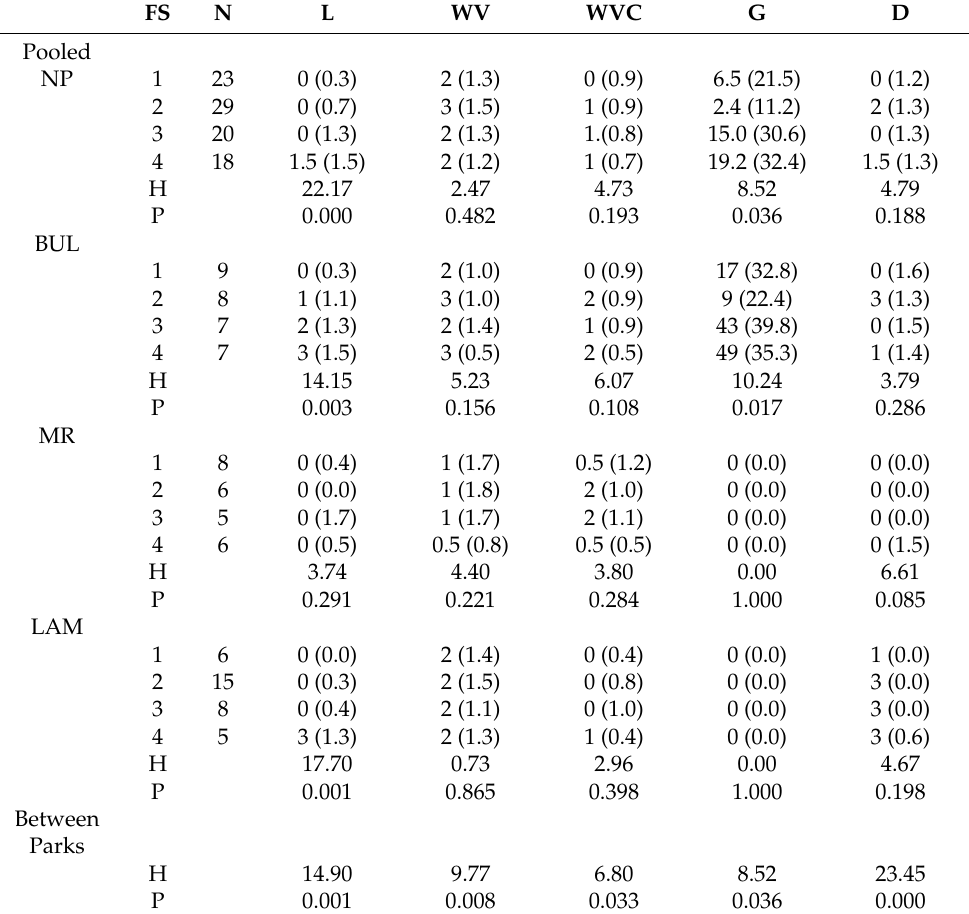
Table 3. Summary table showing the mean or median results of fire-promoting regrowth, for each fire severity in each NP, as well as for pooled NP data. The sample sizes are given (N). For categorical data; L = Lantana (1 = 1–10; 2 = 11–25; 3 = 26–50; 4 = 51–75; 5 = 76+ plants), WV = Woody Vines (1 = few vines, 2 = 1; 3 = 2–3; 4 = 4–5; 5 = 6+ towers), D= Disturbance (1 = branches, 2 =